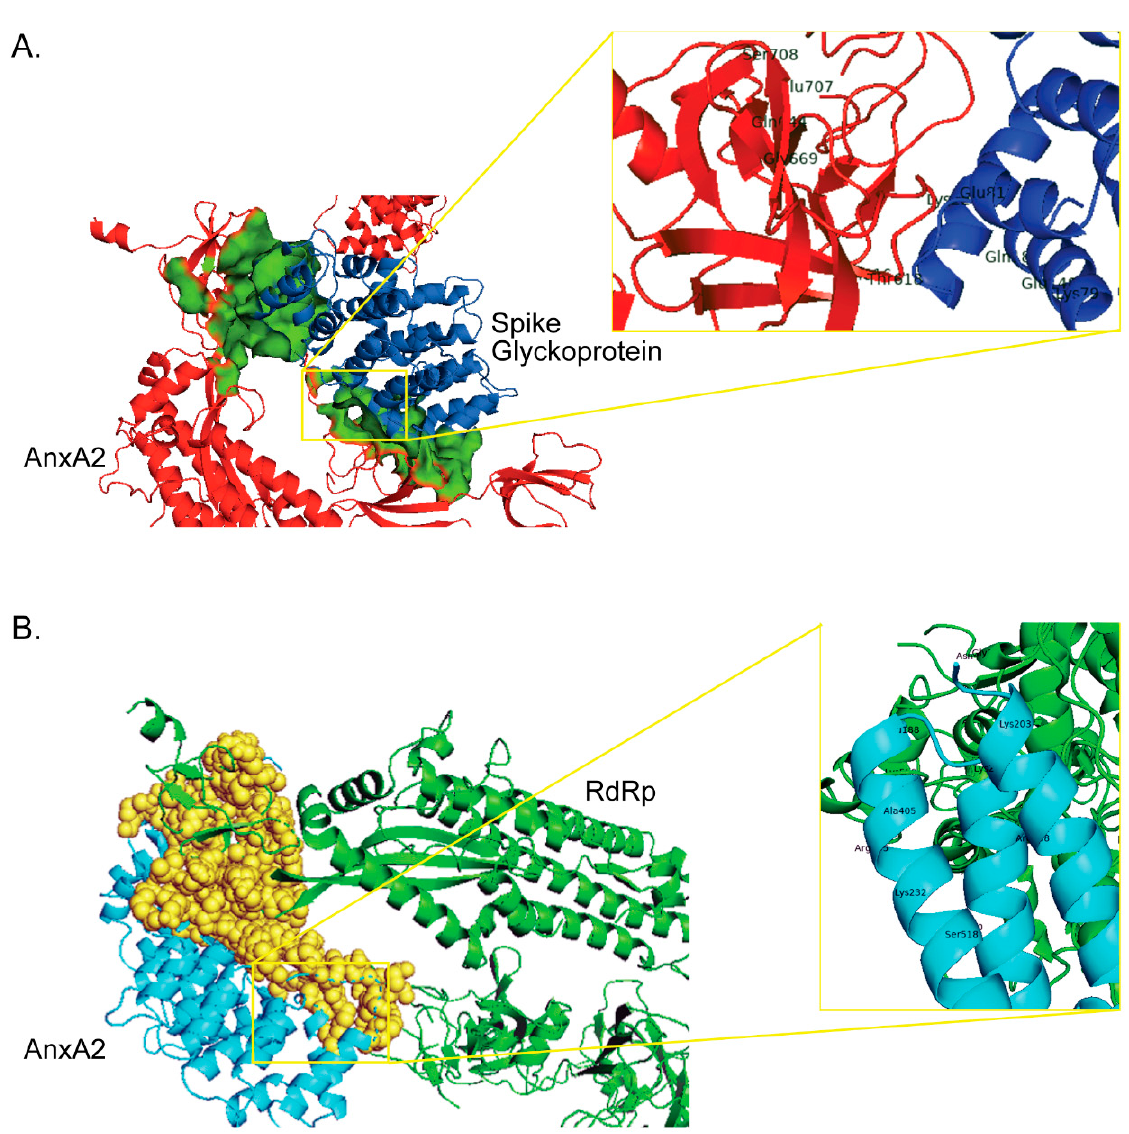
Figure 2. The low-energy binding conformations generated by molecular docking of human AnxA2 with spike glycoprotein ( A ) and RNA-dependent RNA polymerase ( B ) of SARS-CoV-2. The close-up image shows the detailed view of the interacting residues in the region where human AnxA2 bound to spike glycoprotein and RdRp of SARS-CoV-2.